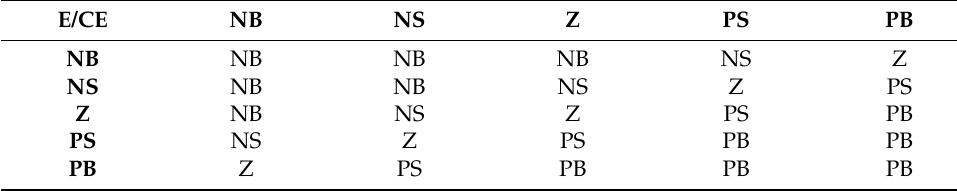
Table 3. Fuzzy Logic Control Rule